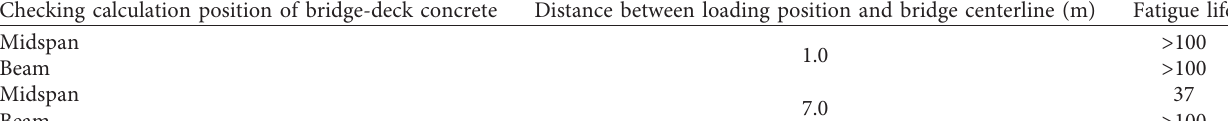
Table 7: Fatigue life of the bridge-deck concrete.